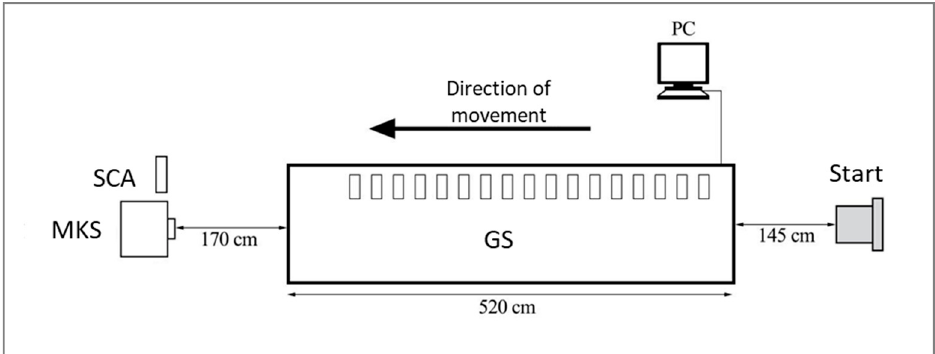
Figure 1. Experimental setup.